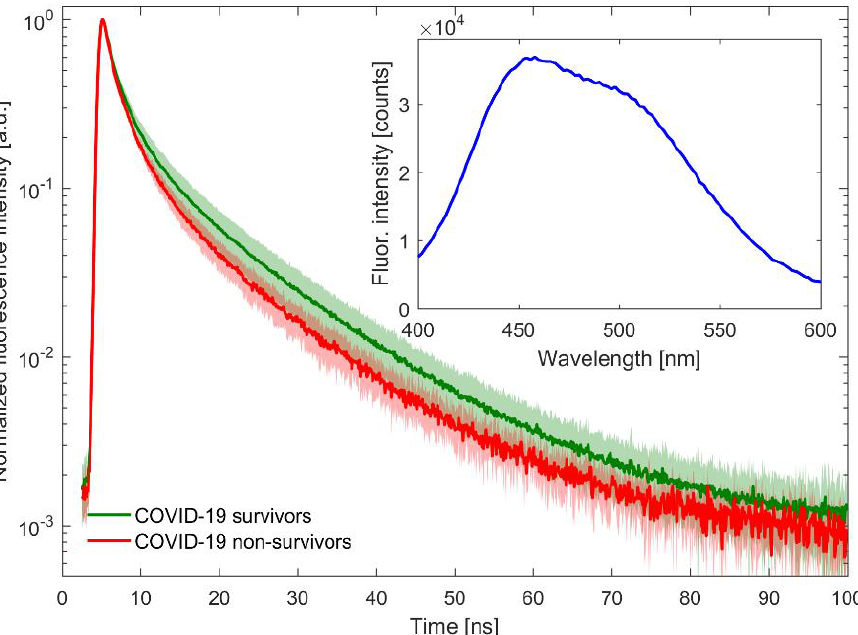
Figure 1. Fluorescence decay curves of plasma samples from patients who survived (green line) and did not survive (red line) COVID-19. Averaged normalized decay curves with corresponding one- standard-deviation bands are presented on the main plot. The inset plot shows typical fluorescence spectra of examined samples.